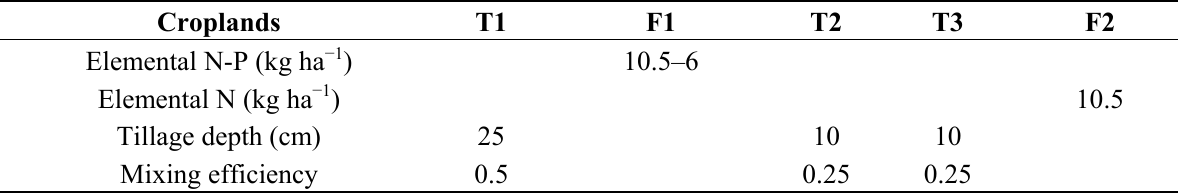
Table 1. Management operations considered for croplands in the Donga-Pont catchment. T1, T2 and T3: Tillage operation; F1 and F2: Fertilization.